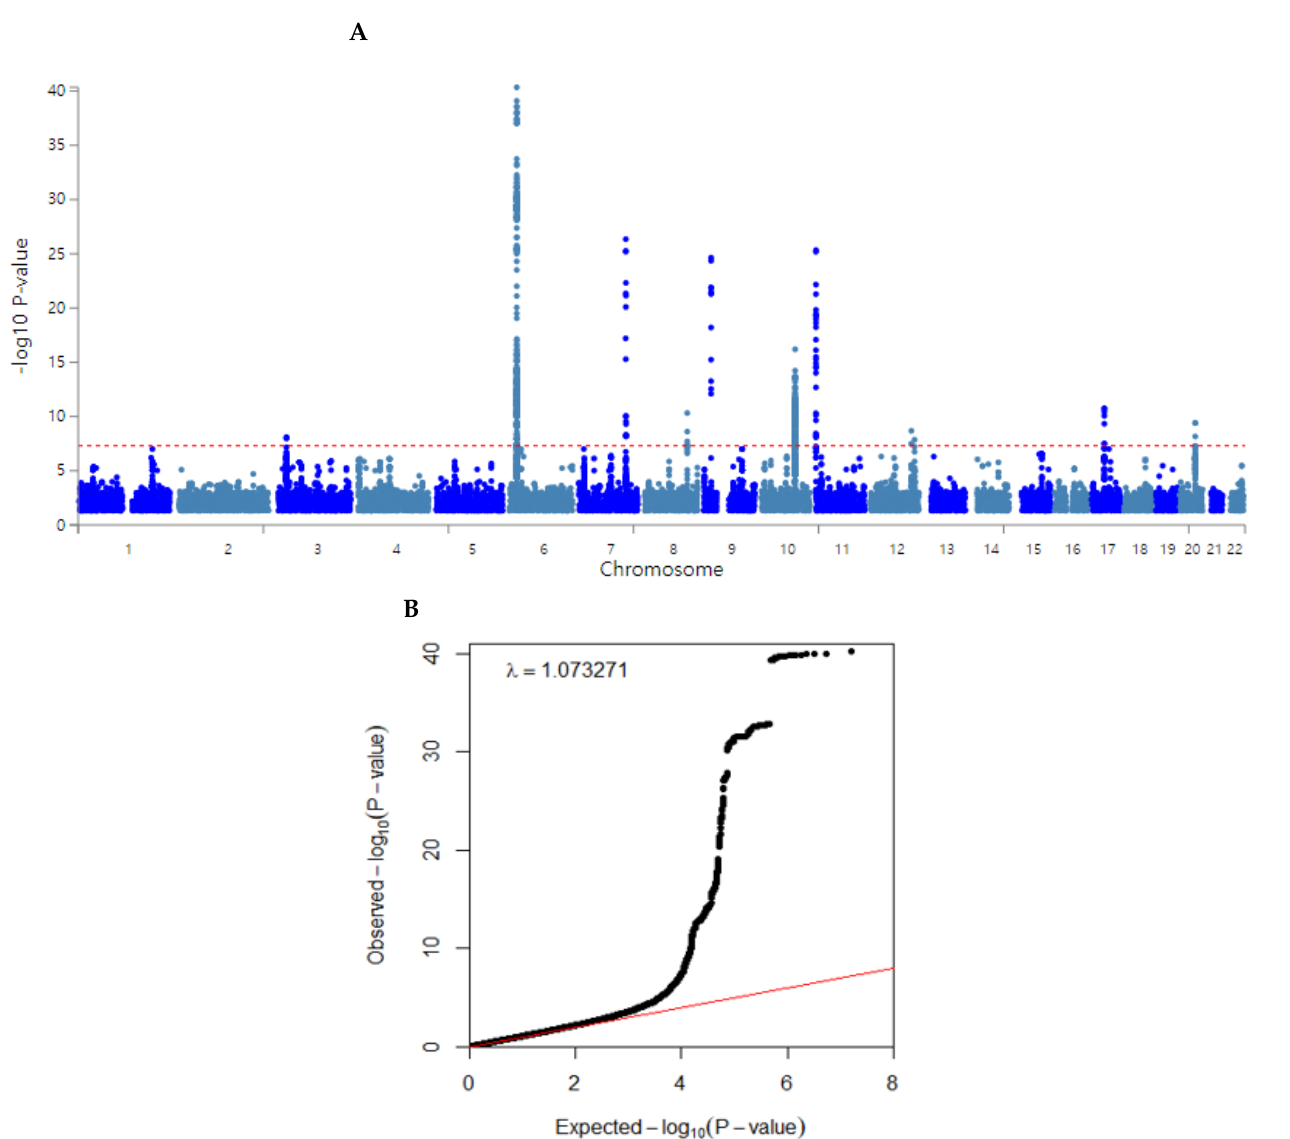
Figure 2. Distribution of genetic variants for type 2 diabetes risk by genome-wide association study: ( A ) Manhattan plot of the p -value of genetic variants for type 2 diabetes risk. ( B ) Q–Q plot of observed and expected p -values for type 2 diabetes risk by genome-wide association.